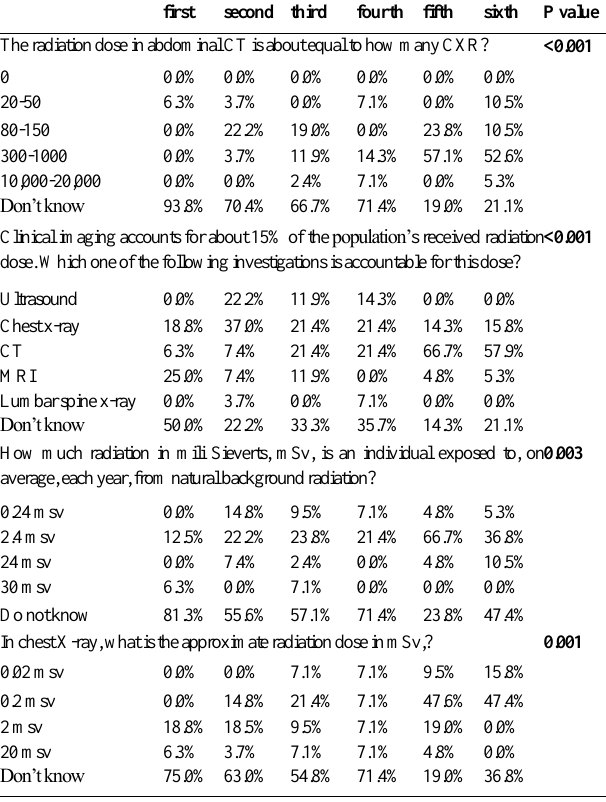
Table 4 : General awareness of the study participants regarding the radiation exposure associated with diagnostic imaging examinations: